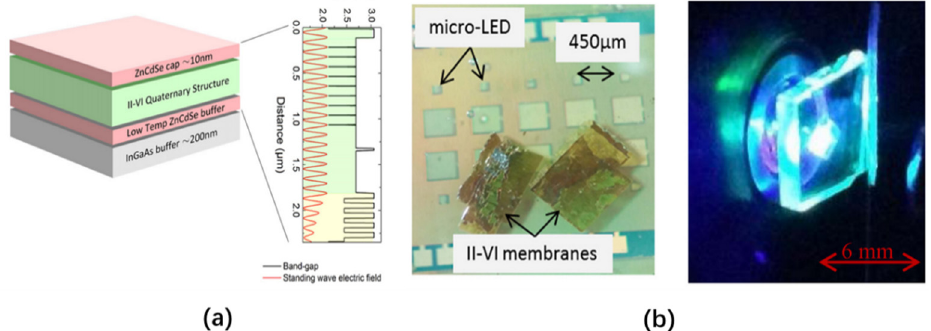
Figure 14. ( a ) II-VI multiple quantum well (MQW) structure design, ( b ) top view micrograph of the mixing device and the effect of II-VI film when excited by a blue LED. Reproduced from [90], Institute of Physics, 2015.